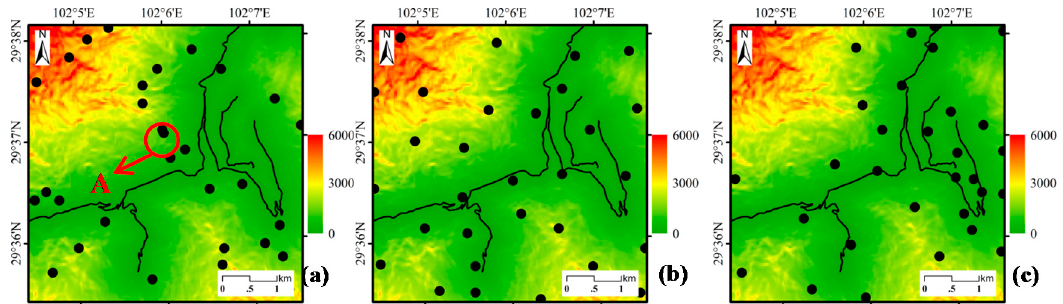
Figure 4. NDVI ( a ) and slope ( b ) frequency distribution histograms of 30 selected sampling plots given by VTB, CLH and CSS sampling strategies and of the entire study area. VTB, CLH, and CSS refer to vegetation type-based, traditional conditioned Latin hypercube, and cost-constrained sampling strategies, respectively.